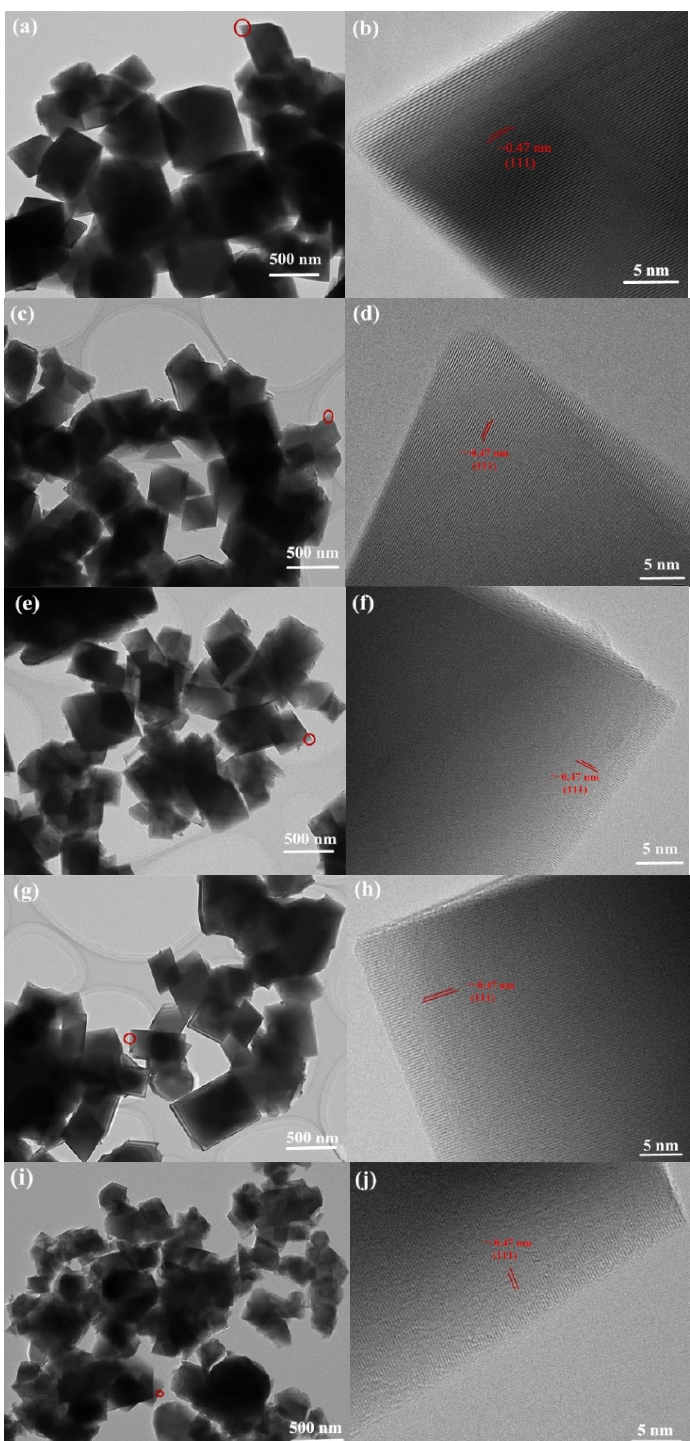
Figure 6. TEM and HR-TEM images of pure LNMO ( a,b ), LNMO-KCl0.02 ( c,d ), LNMO-KCl0.03 ( e,f ), LNMO-KF0.01 ( g,h ), and LNMO-KF0.02 ( i,j ).